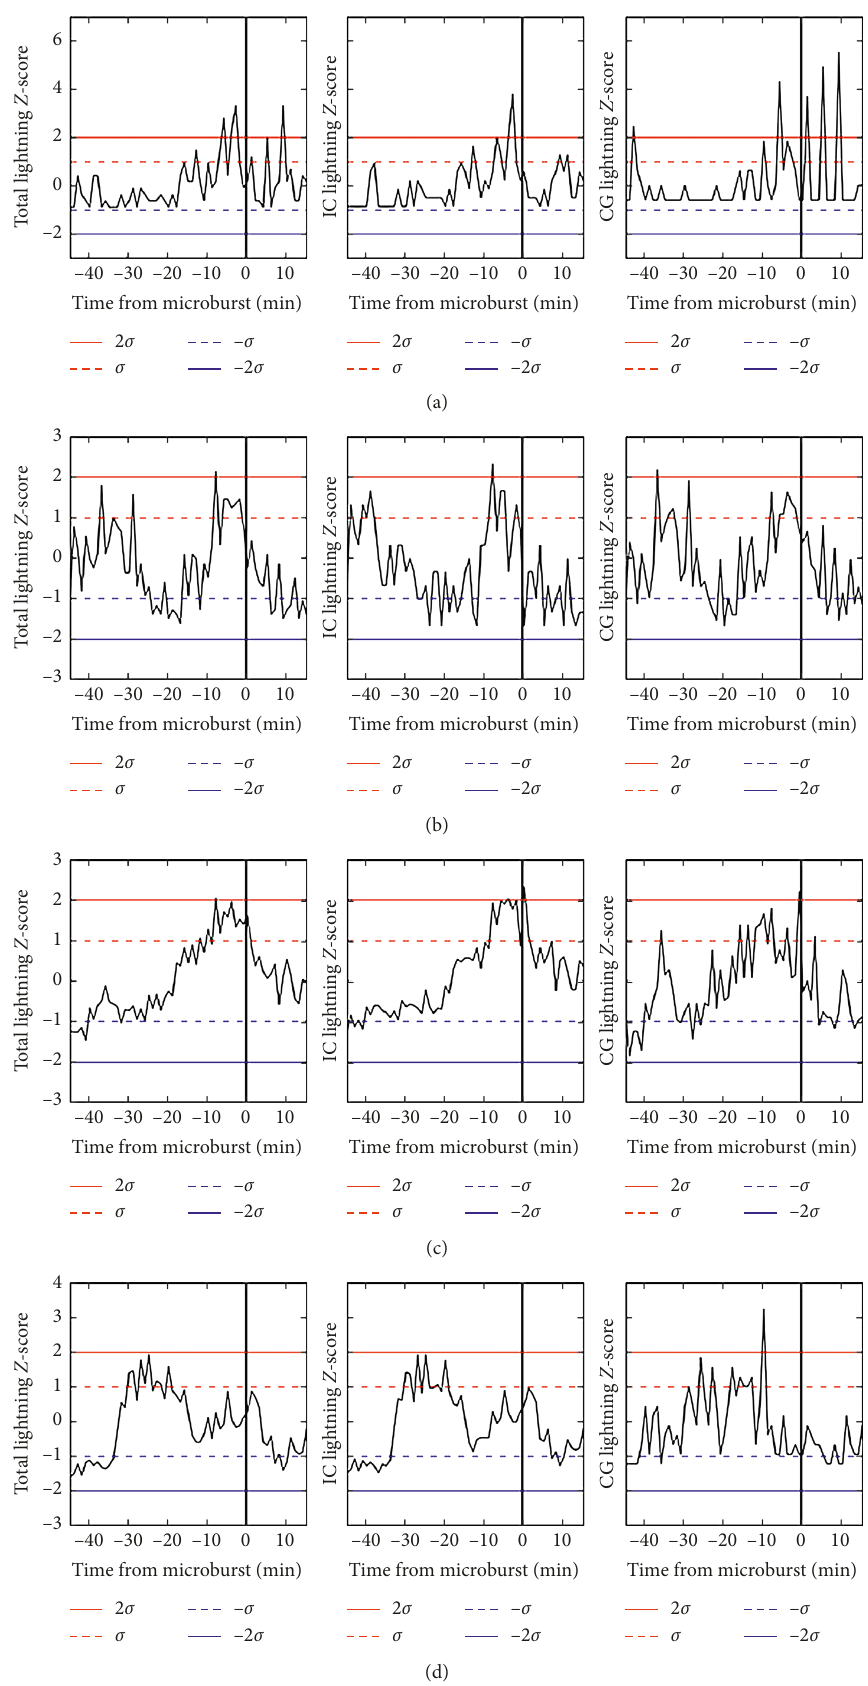
Figure 4: As in Figure 3, except for the next four cases. (a) 20140708PA microburst. (b) 20150612 microburst. (c) 20150623 microburst. (d) 20150630